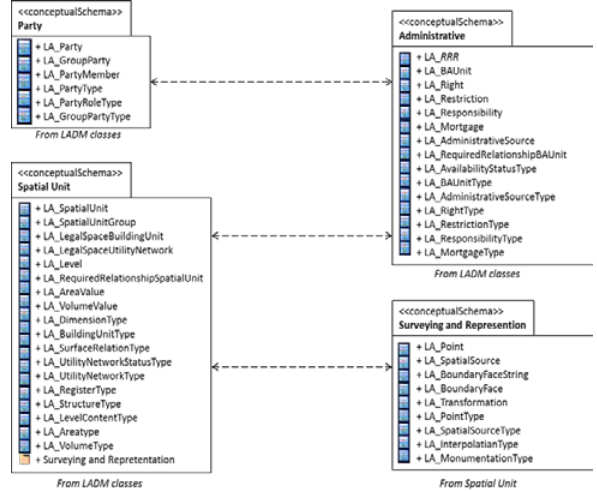
Figure 1: The LADM overview of (sub) packages (with their respective classes) (ISO, 2012).